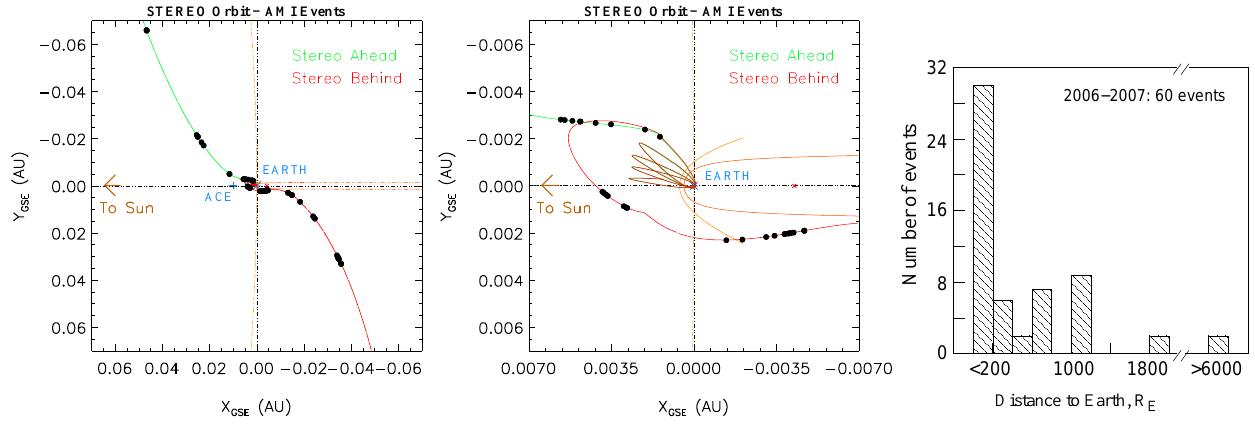
Fig. 6. The spatial distribution of AMI events observed along the both STEREO-A & B orbits (green and red lines) during the time interval from 15 December 2006 to 29 April 2007. Each event (black point) are shown in relation to the Earth’s bow–shock and the magnetopause (orange lines). The Sun is to the left. The right panel presents the number of AMI events as a function of radial distance from the Earth. Predominately, the AMIs occur at distances smaller than 200 R E , but there are still events observed further than 1800 R E . The two events near 6000 R E are associated with the passage of a IP shock.